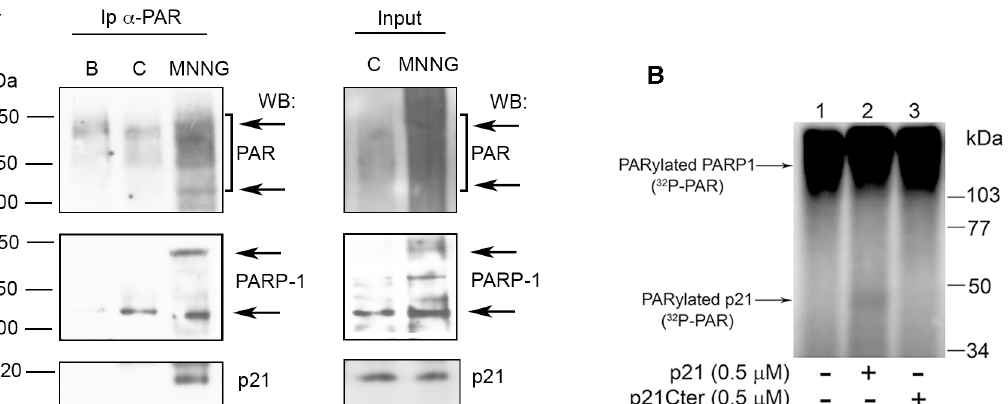
Fig 3. Interaction of p21 with PAR in vivo . ( A ) Immunoprecipitation (Ip) of p21 with polyclonal anti-PAR antibody from soluble (B), or nuclear extracts of LF- 1 human fibroblasts untreated controls (C), or cells treated with 25 μ M MNNG (MNNG). Input shows 10% of nuclear extracts before Ip. The samples were separated by SDS-PAGE and analysed by Western blot for PAR (10H antibody), PARP-1 (F1-23 antibody), and p21 (CP74 antibody). The arrows indicate the position of unmodified (upper) and PARylated (lower) forms of PARP-1. ( B ) PARylation of p21. Purified PARP1 (70 nM) was incubated without (lane 1, − ), or with 500 nM p21 (lane 2, +) or p21C-term (lane 3, +) in the presence of [ 32 P]-NAD + and 0.1 A 260 /ml of DNase I-activated calf thymus DNA for 15 min at 37°C. Samples were analysed by 10% SDS-PAGE followed by phosphorimaging.